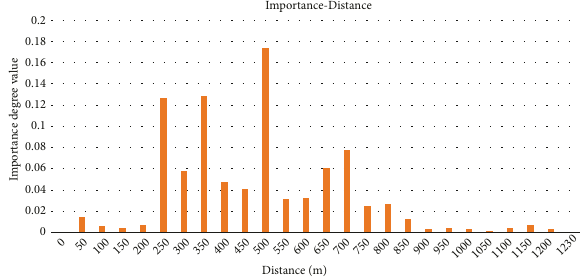
Figure 9: Importance of velocity at different locations in the section.